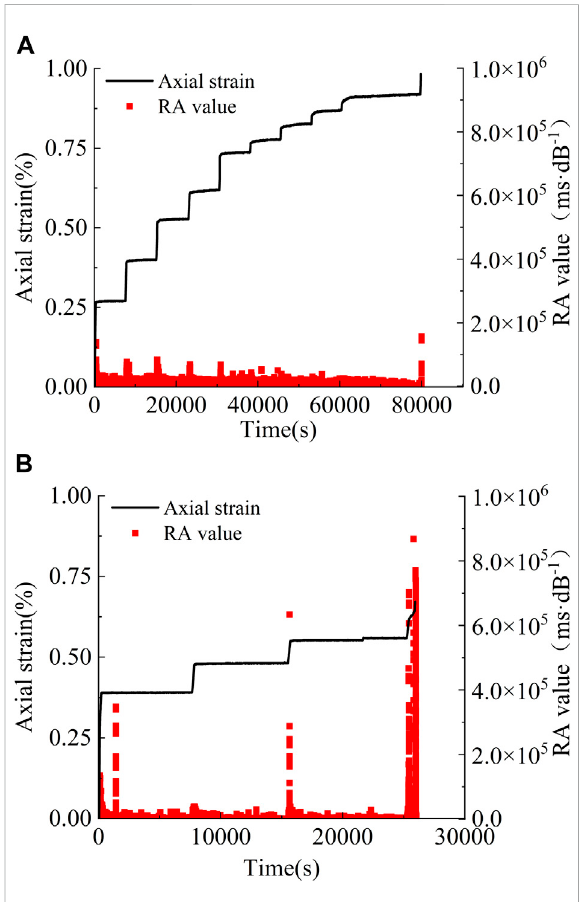
FIGURE 12 Axialstrain-RAvalue-timecurveofspecimens. (A) RAvalueof Intact specimen. (B) RA value of prefabricated fi ssures specimen.